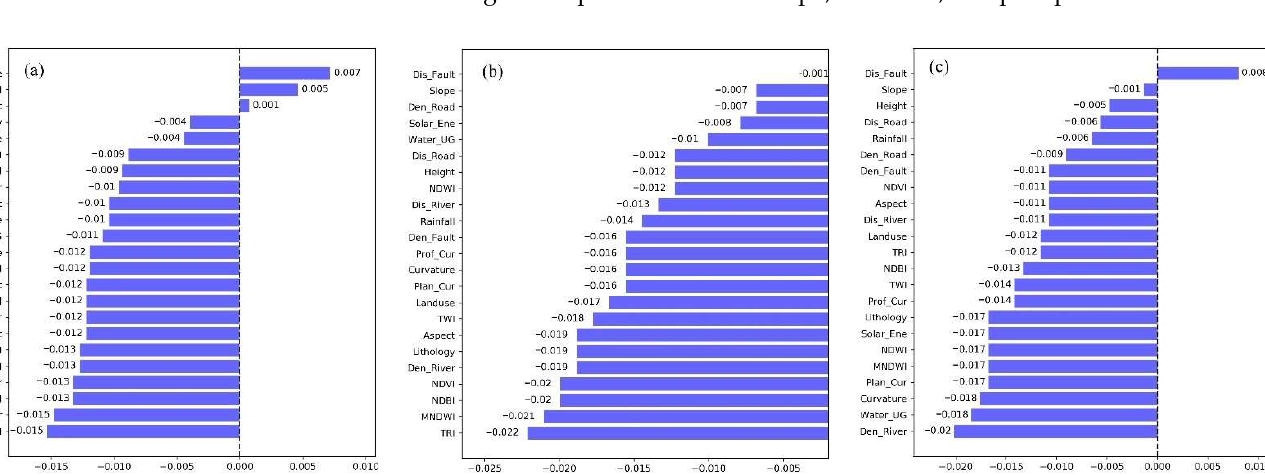
Table 7. Changes in model score and AUC after using filter-MDA feature selection method.